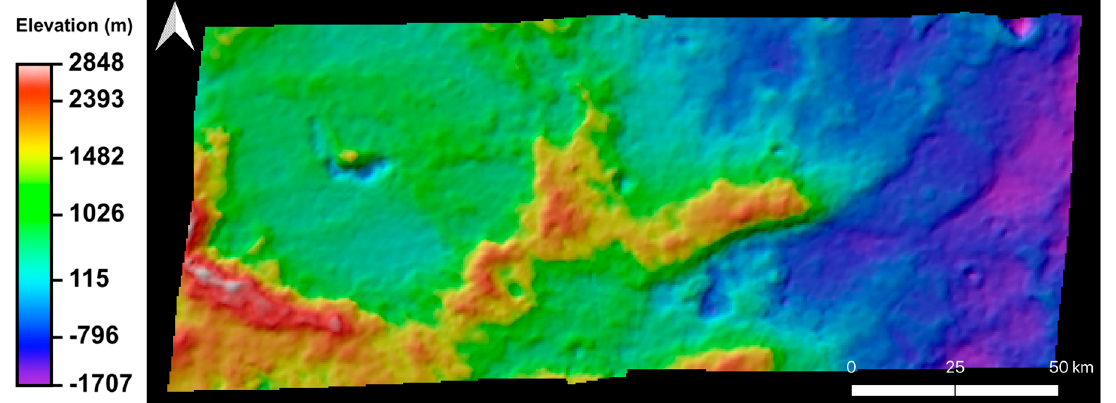
Figure A6. Kuiper Crater.